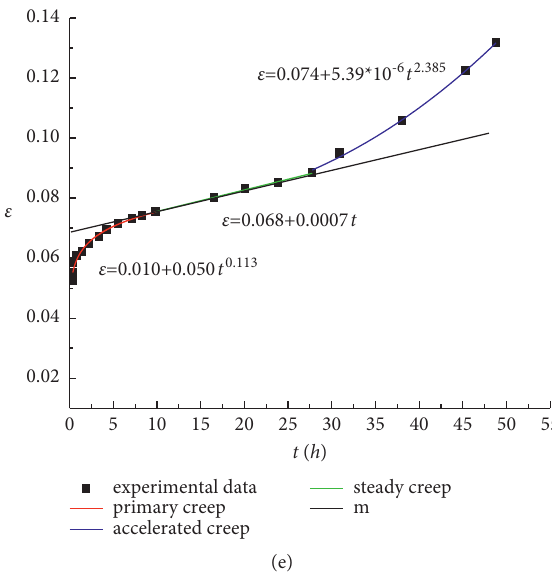
Figure 9: Fitting creep curves of coal (rock) with different moisture contents. (a) Fitting curve of coal (rock) with a moisture content of 0%. (b) Fitting curve of coal (rock) with a moisture content of 0.71%. (c) Fitting curve of coal (rock) with a moisture content of 1.45%. (d) Fitting curve of coal (rock) with a moisture content of 1.83%. (e) Fitting curve of coal (rock) with a moisture content of